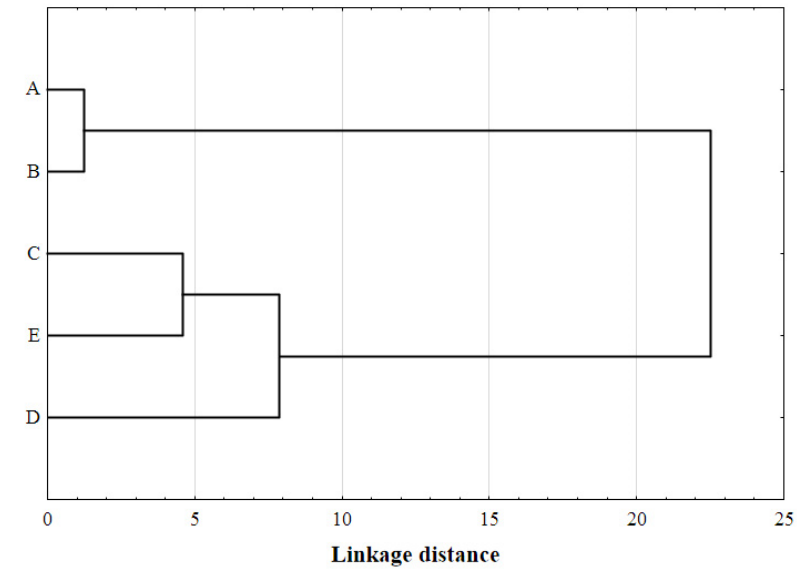
Figure 3. Cluster analysis - Ward’s method with Euclidean